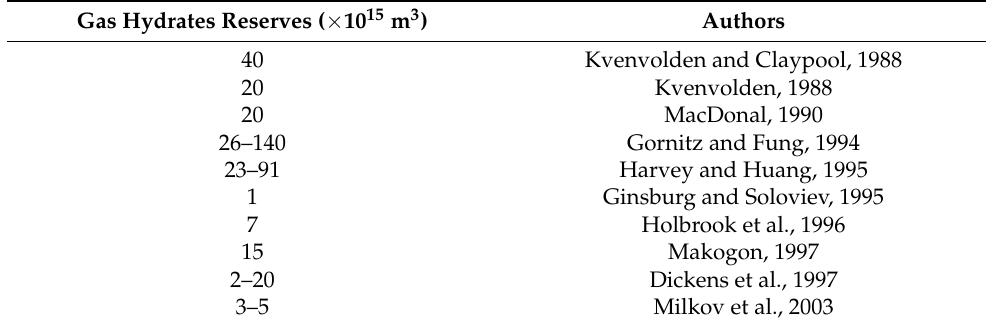
Table 2. The estimations of gas hydrate reserves (Modification of the Table 2 [27], p.